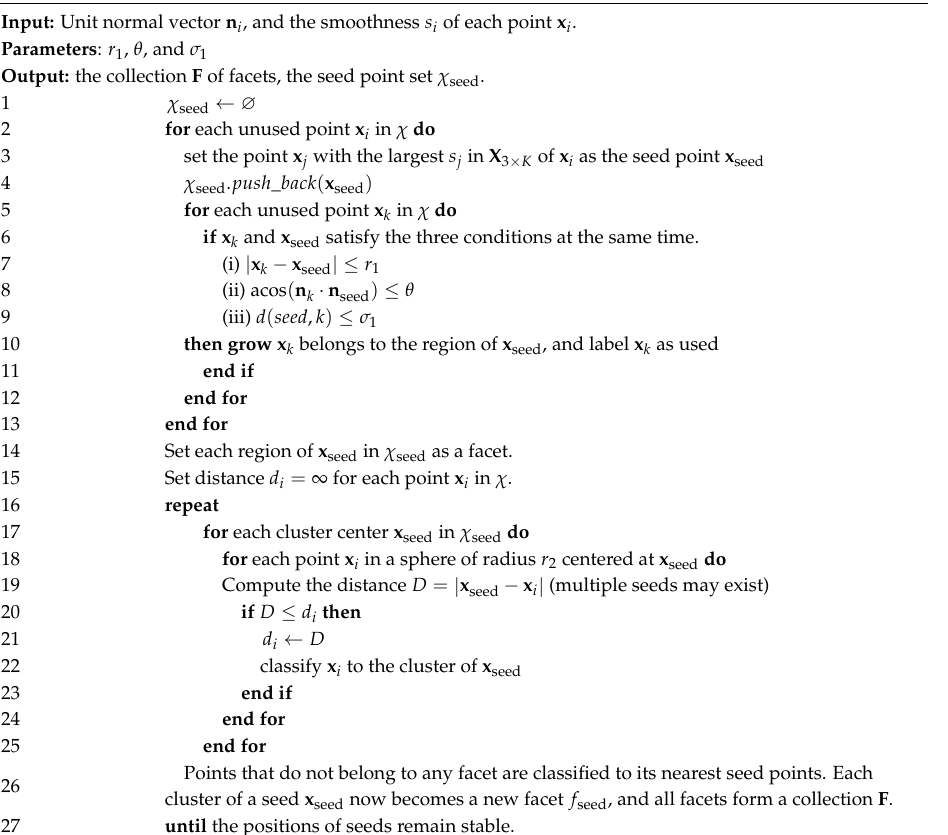
Algorithm 2 Facet